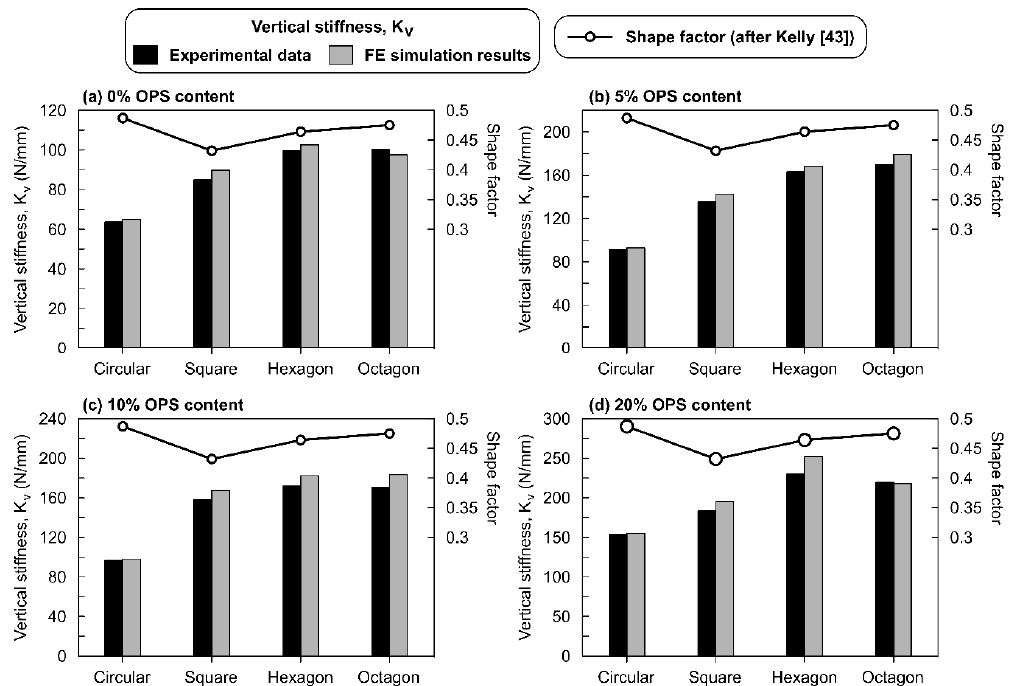
Figure 8. Variation of the shape factor values and vertical stiffness obtained for different shapes in this study: ( a ) 0% OPS; ( b ) 5% OPS; ( c ) 10% OPS; ( d ) 20% OPS. study: ( a ) 0% OPS; ( b ) 5% OPS; ( c ) 10% OPS; ( d ) 20%